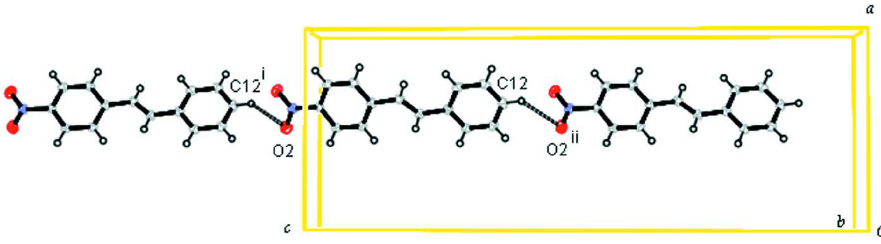
Figure 3 Part of the crystal structure of (I) showing the formation of C (13) chains along [001]. [Symmetry codes: (i) x , 1/2 - y , 1/2 + z ; (ii) x , 1/2 - y , -1/2 + z ;